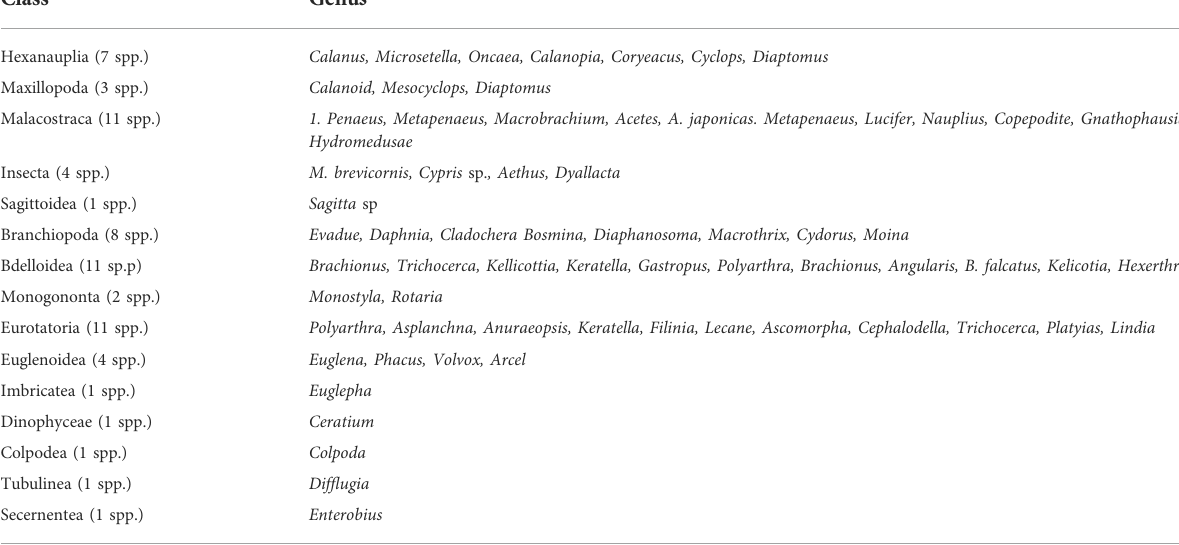
TABLE 6 Diversity of zooplankton (67 spp.) in the estuarine waters of Bangladesh.